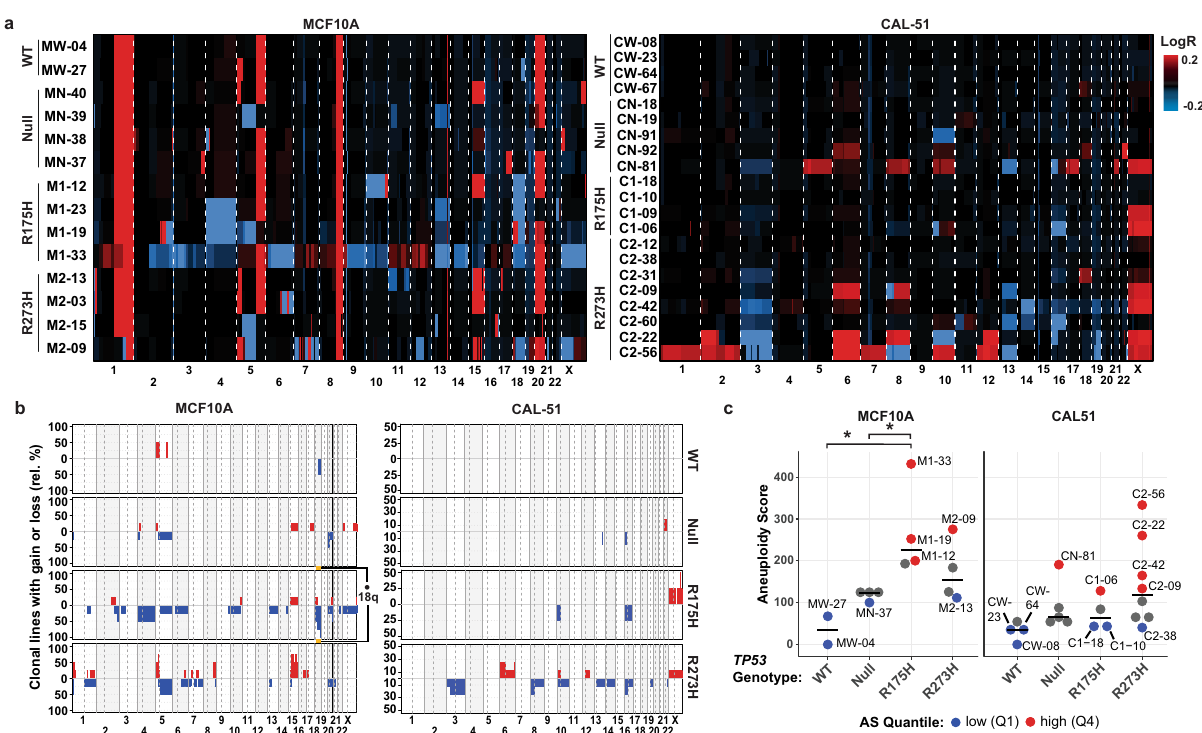
Fig. 2 p53 mutant isogenic cell lines display increased frequency of aneuploidy. a Copy number alterations (Log 2 ratios, LogR) in MCF10A (left) and CAL-51 (right) isogenic cell lines grouped by TP53 genotype. Chromosomal gain (red) and loss (blue). b Frequency plots of the proportion of clonal lines from each genotype containing the indicated chromosomal copy number gains (red) or losses (blue). Chromosomal alterations were calculated relative to the parental WT clone in the MCF10A (left) and CAL-51 (right) cell lines from a . Chromosome 18q in the R175H mutant MCF10A cells was the only region signi fi cantly altered; (cid:129) adjusted P < 0.1, two-sided Student ’ s t -test comparing chromosome arms between TP53 genotypes. c Aneuploidy score (AS) in each MCF10A (left) and CAL-51 (right) cell line by TP53 genotype (MCF10A n = 2 WT, 4 Null, 4 R175H, and 4 R273H cell lines; CAL-51 n = 4 WT, 5 Null, 4 R175H, and 8 R273H cell lines). Colors indicate cell lines classi fi ed as aneuploid-low (lower quantile AS [Q1], blue), and aneuploid-high (upper quantile AS [Q4], red). Cell lines colored in gray indicate an intermediate AS (quantiles 2 and 3). * P < 0.05 (WT vs R175H, P = 0.011; Null vs R175H, P = 0.046), one- way ANOVA with Dunnett ’ s multiple comparison test. Source data are provided in the Source Data mutant and null genotypes (Fig. 2a), consistent with other analyses of tetraploid cells 38 .